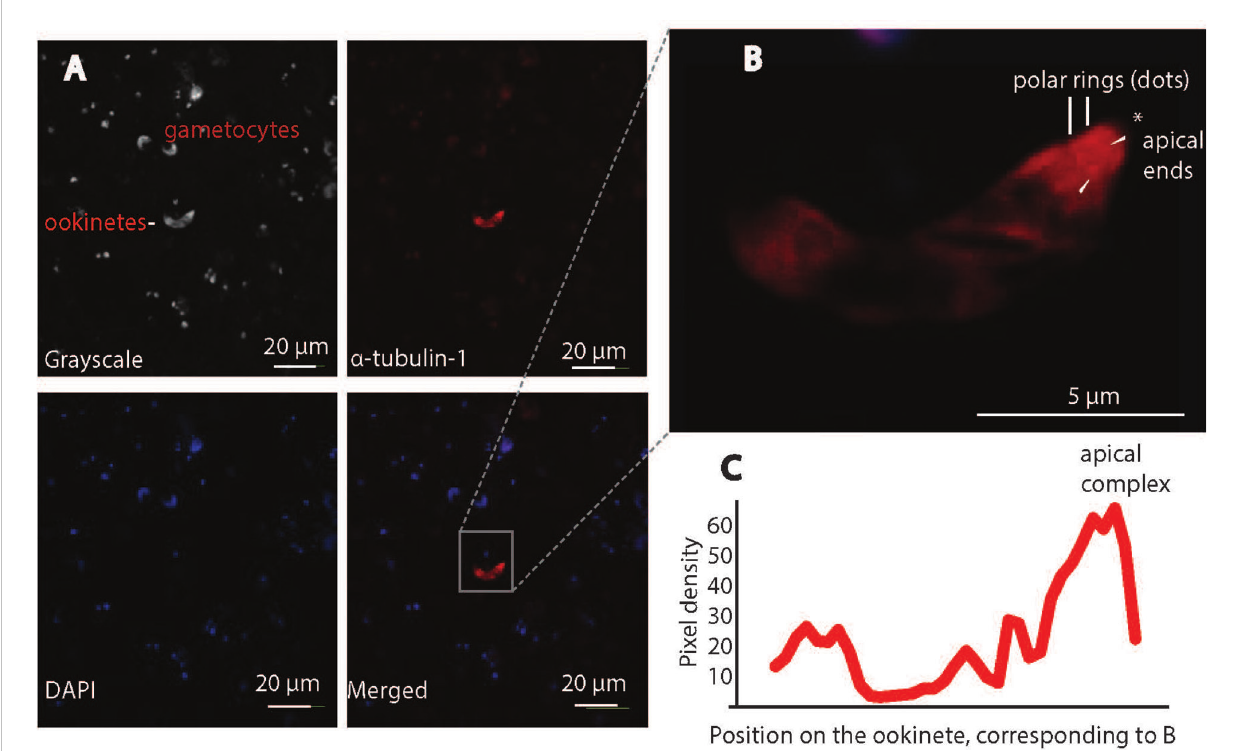
FIGURE 8 Confocal immuno fl uorescence assays con fi rm P. falciparum a -tubulin-1 protein on the live ookinete surface. (A) a -tubulin-1 was detected on the live ookinete surface and not on the gametocyte surface. (B) Higher magni fi cation showing the ookinete invasion apparatus of the ookinete (protrusion) and the strongest signals (red dots) evenly distributed at the apical polar rings (pointed by white arrows). * is the apical end. (C) Two rings at the apical region displayed the highest pixel density of red